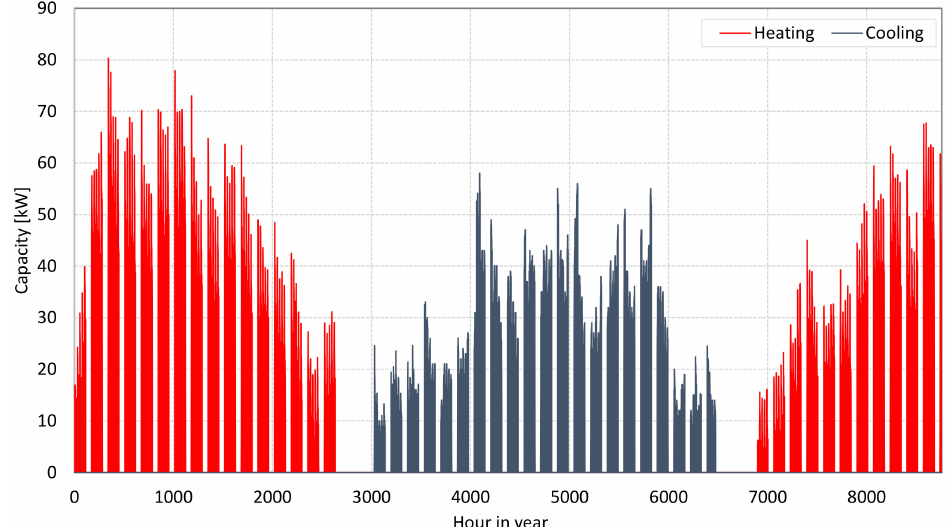
Figure 3. Useful energy for heating and cooling (after implementation of